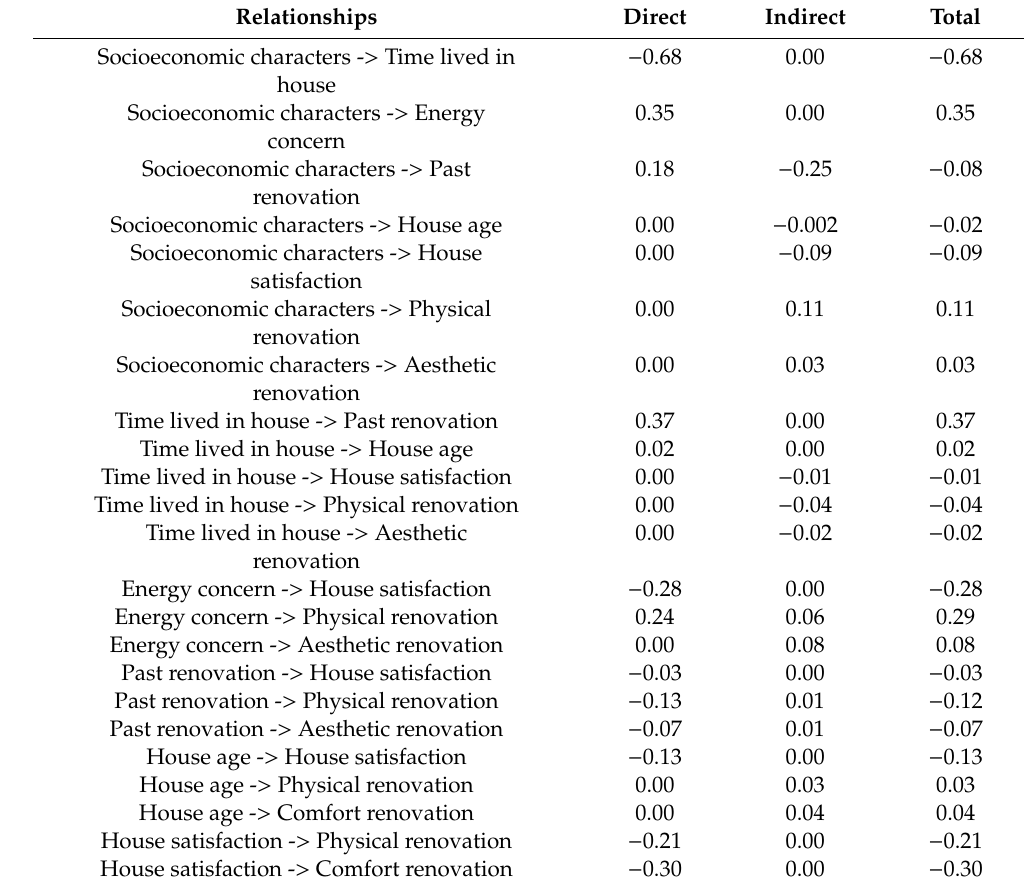
Table 2. Direct, indirect and total e ff ects in the renovation model. Relationships